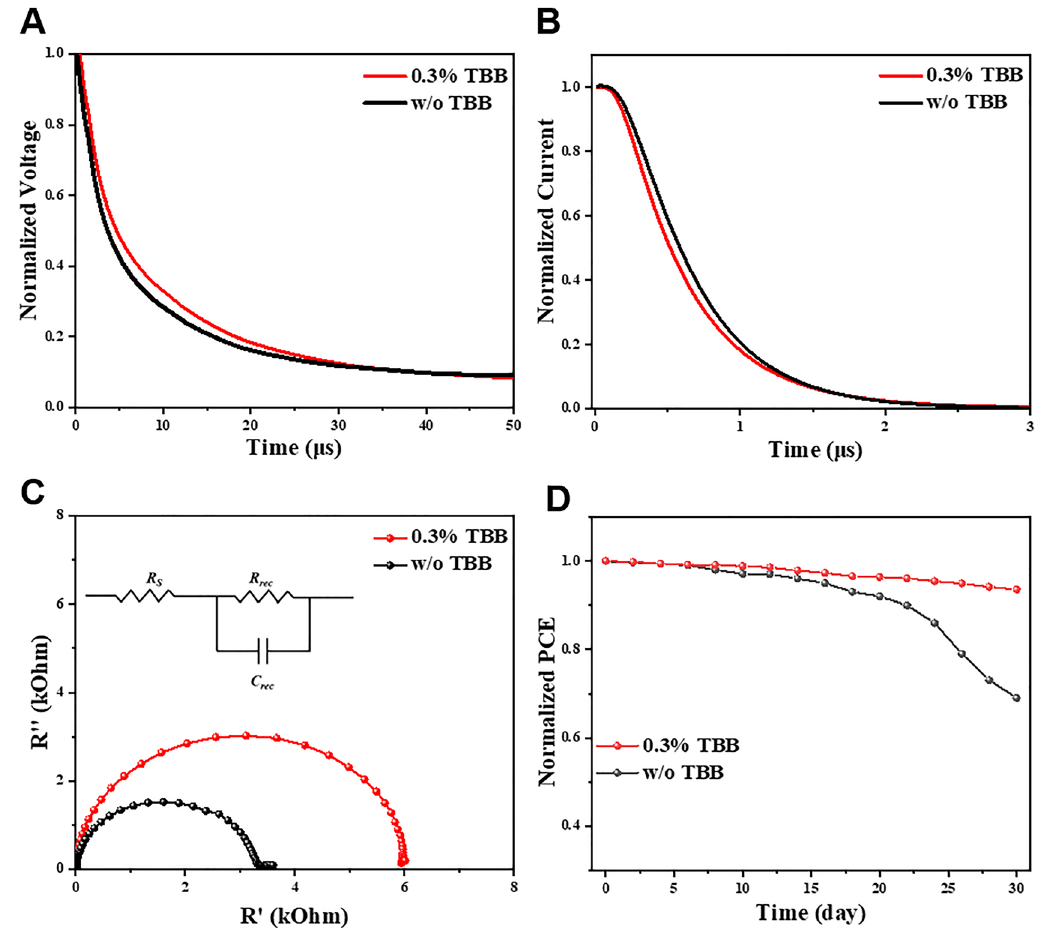
Figure 7: Characterizations of the best-performing wide- E g device without 1,3,5-tris (bromomethyl) benzene (TBB) and with 0.3% TBB. (A) Transient photovoltaic (TPV) curves. (B) Transient photocurrent (TPC) curves. (C) Nyquist plots. (D) Device